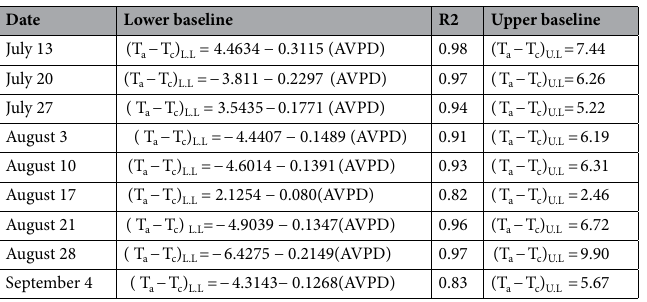
Table 7. Equations for lower and upper baselines at different dates of the black gram growth period. (T